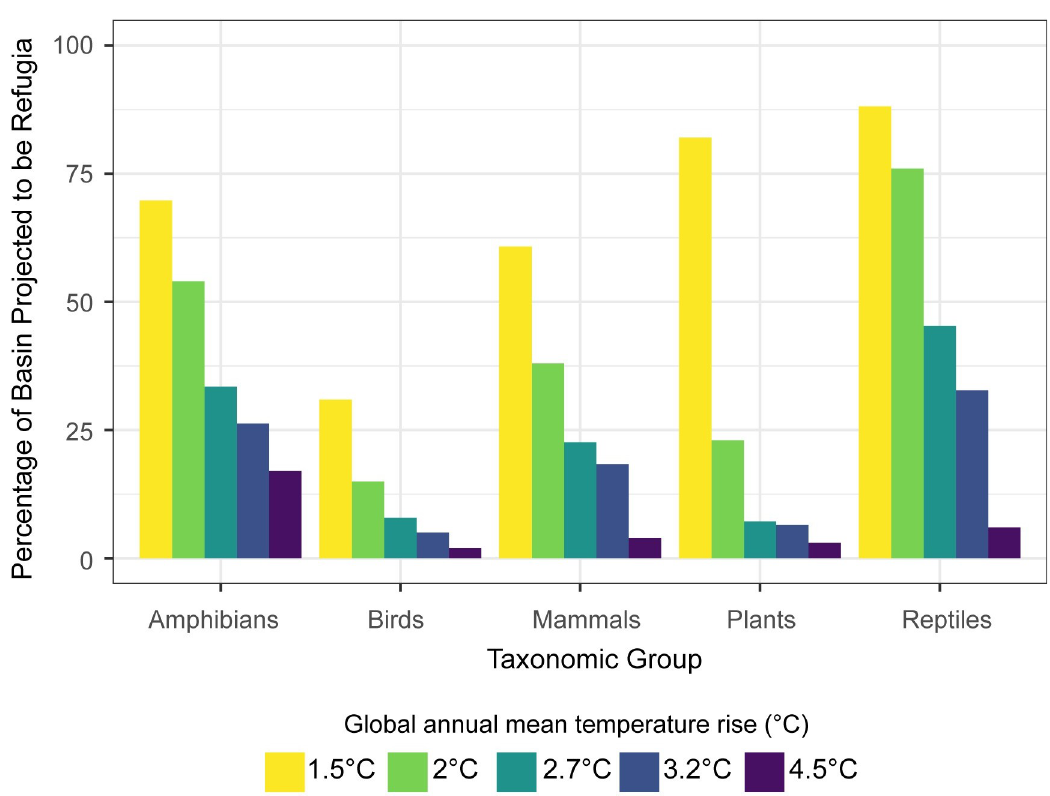
Fig 3. Percentage of the Tana River Basin projected to contain refugia with different warming levels. Refugia are areas where at least 75% of the current species richness is able to persist in a changing climate by 11+ GCMs for the five taxa (amphibians, birds, mammals, plants and reptiles) with different global temperature